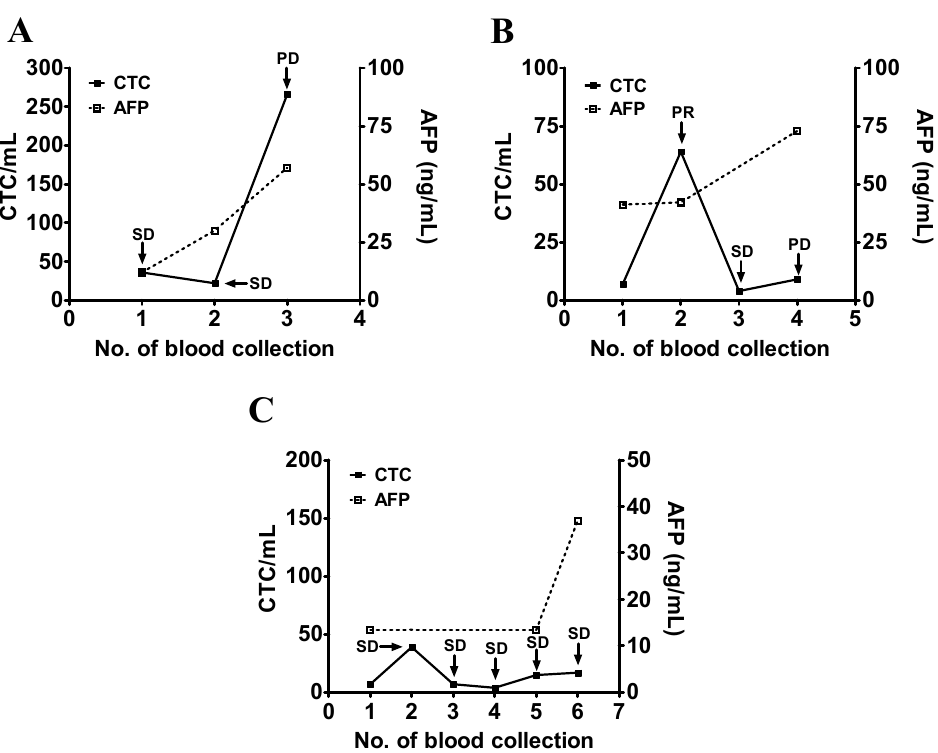
Figure 5. Longitudinal follow-up of CTC counts for monitoring the disease status of patients with HCC (part III). ( A – C ) The blood samples were longitudinally collected from patients #15 (panel A ), #24 (panel B ), and #25 (panel C ), who all had a moderate initial serum AFP level followed by an increase. Series testing of the CTC count and the serum AFP level were performed and plotted accordingly. The disease status (SD, PR, and PD) was determined and was used as an indicator of the patient’s clinical outcome.